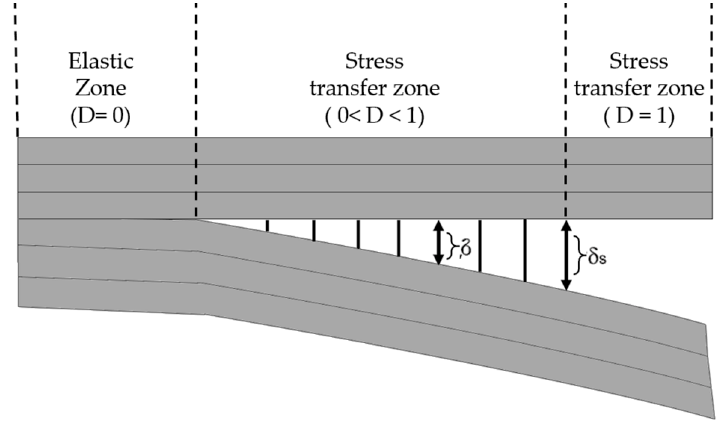
Figure 11. Cohesive zone model to simulate crack propagation.